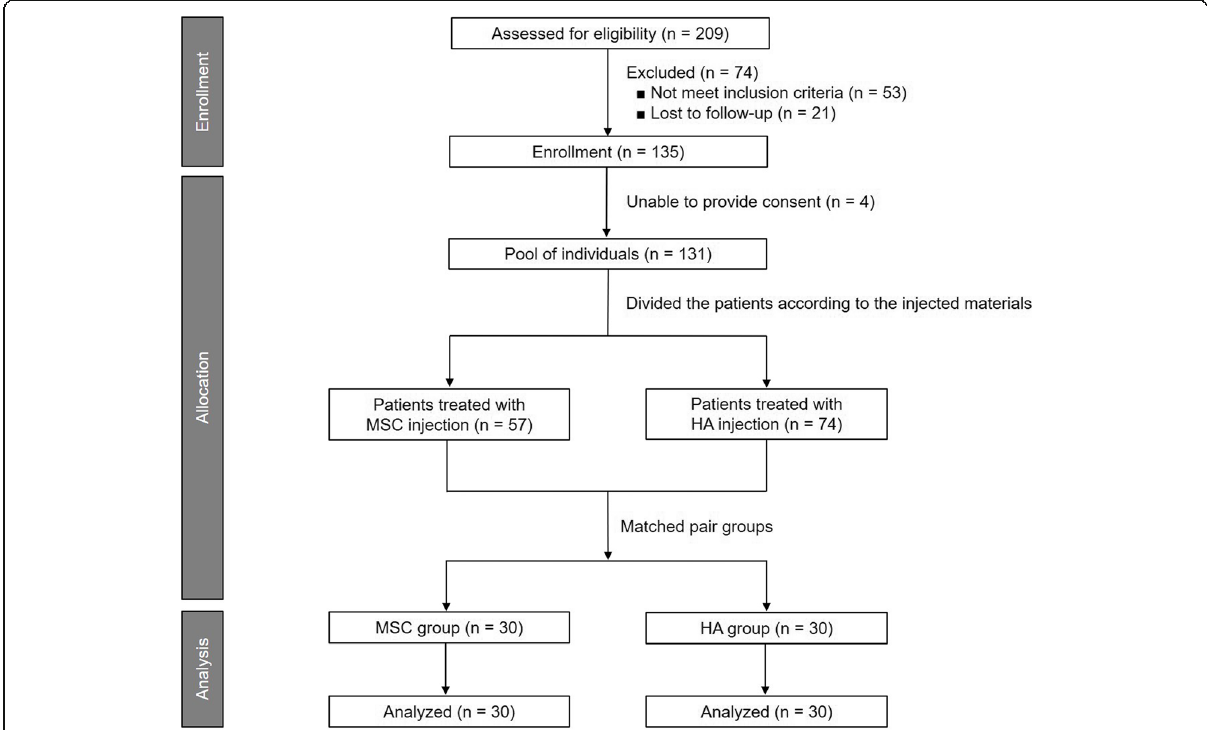
Fig. 1 CONSORT flow diagram depicting the patient enrollment process for this study. MSC, mesenchymal stem cell; HA, hyaluronic